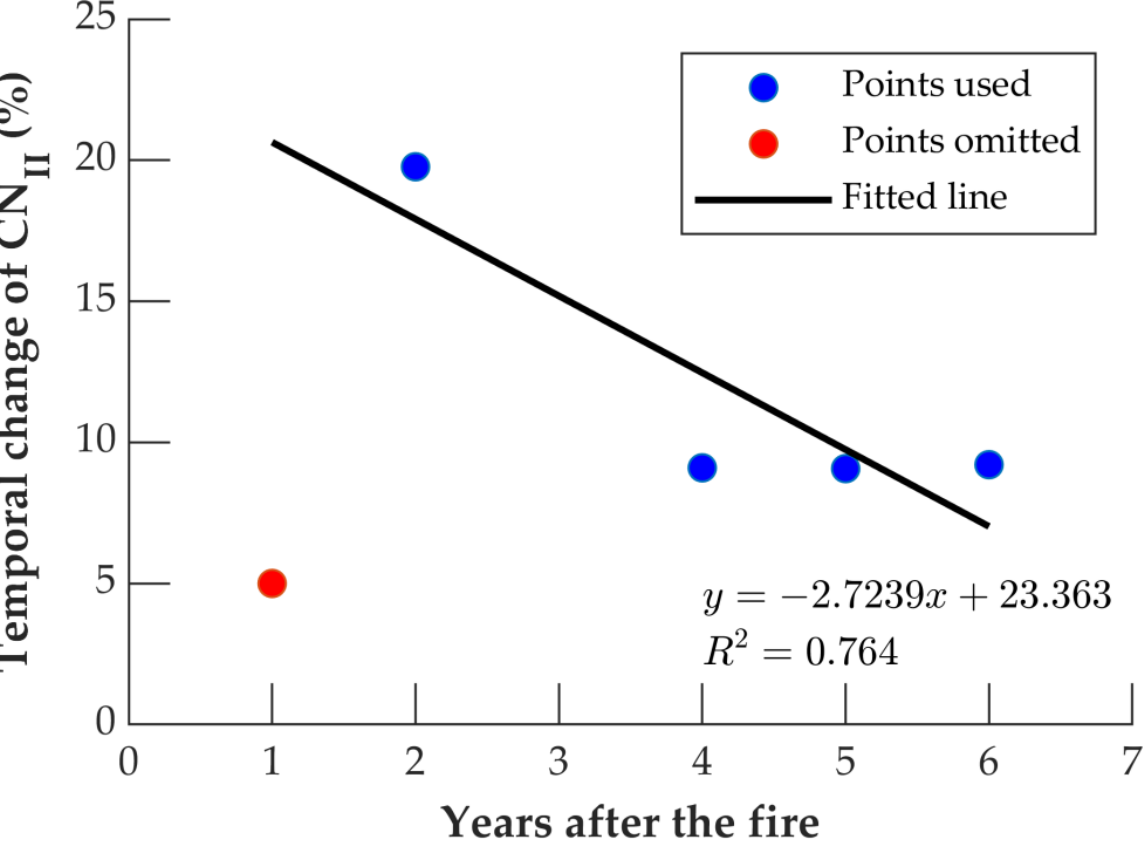
Figure 3. The temporal change of CN II of burnt areas after the fire as a percentage of the pre-fire CN and the fitted linear trendline; CN values were obtained using SWAT; for the third year, the change is out of range [0%, 25%].